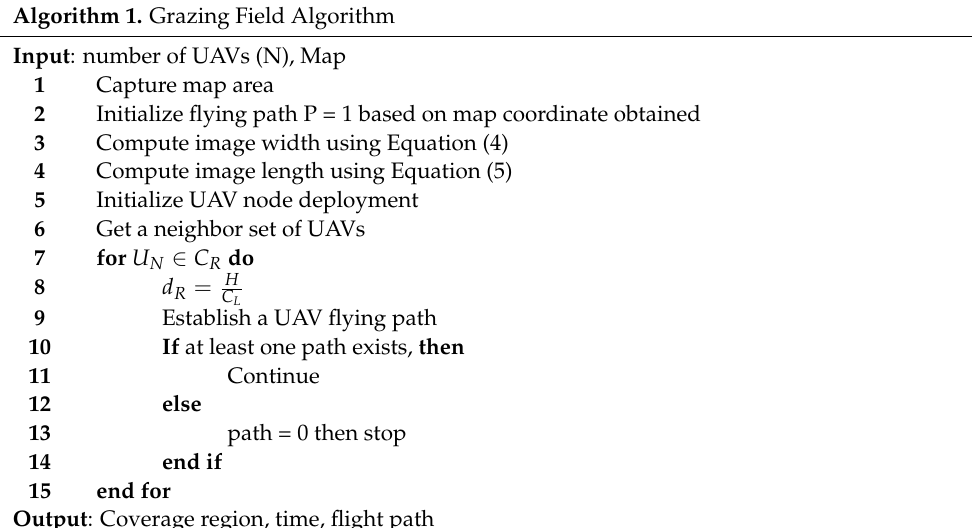
Algorithm 1. Grazing Field